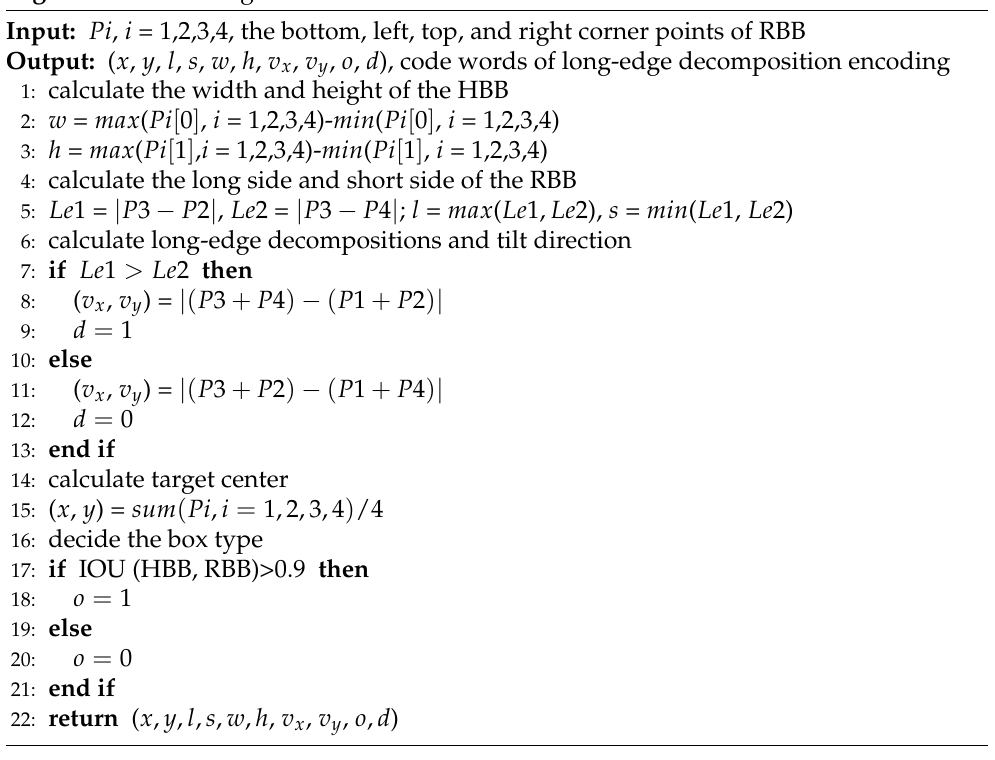
Algorithm 1 Encoding.